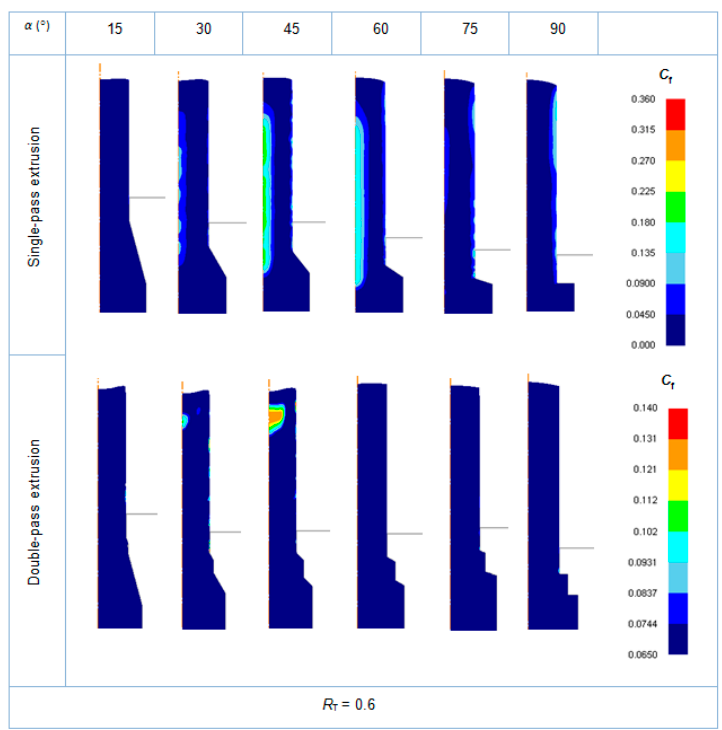
Figure 19. Comparison of damage ( C f ) induced with single-pass dies vs. the best configurations of double-pass dies with R T = 0.6.